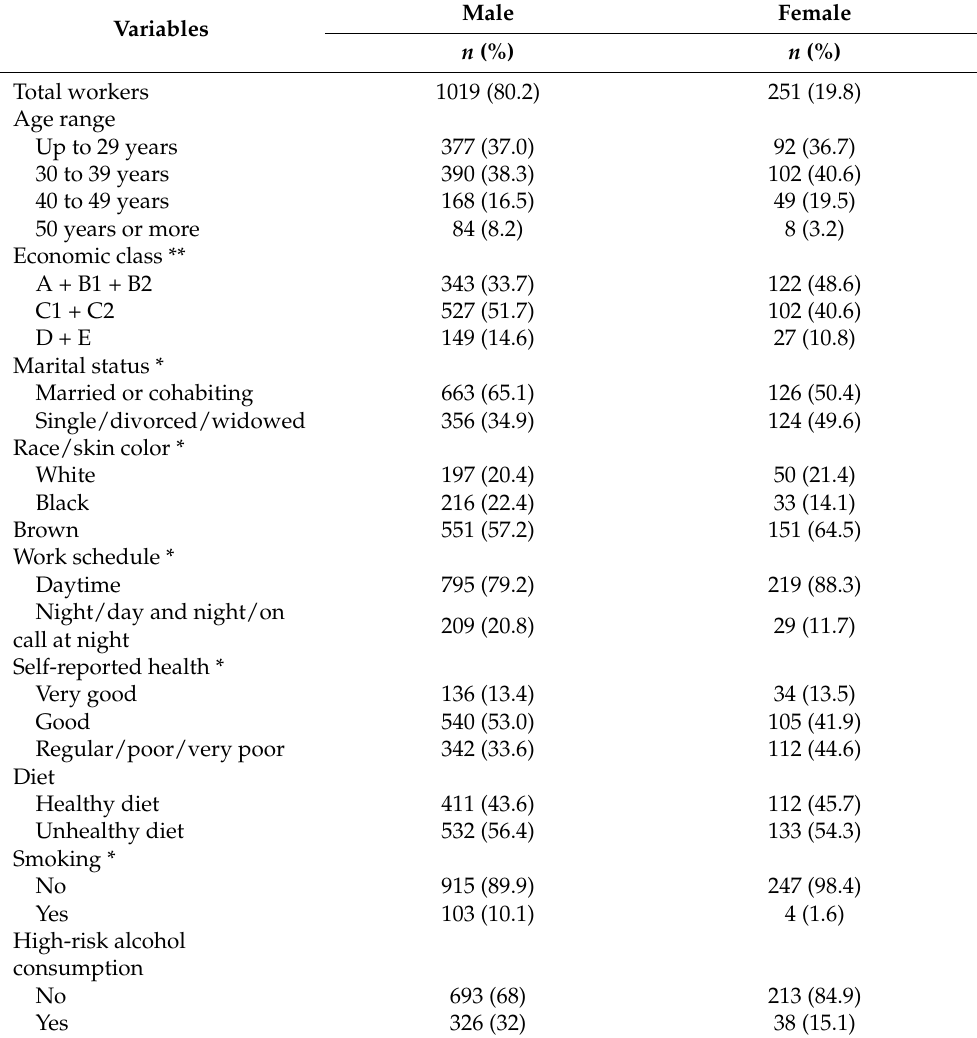
Table 1. Sociodemographic, economic, clinical, and behavioral characteristics of workers in the Industrial Social Services of Vit ó ria da Conquista.